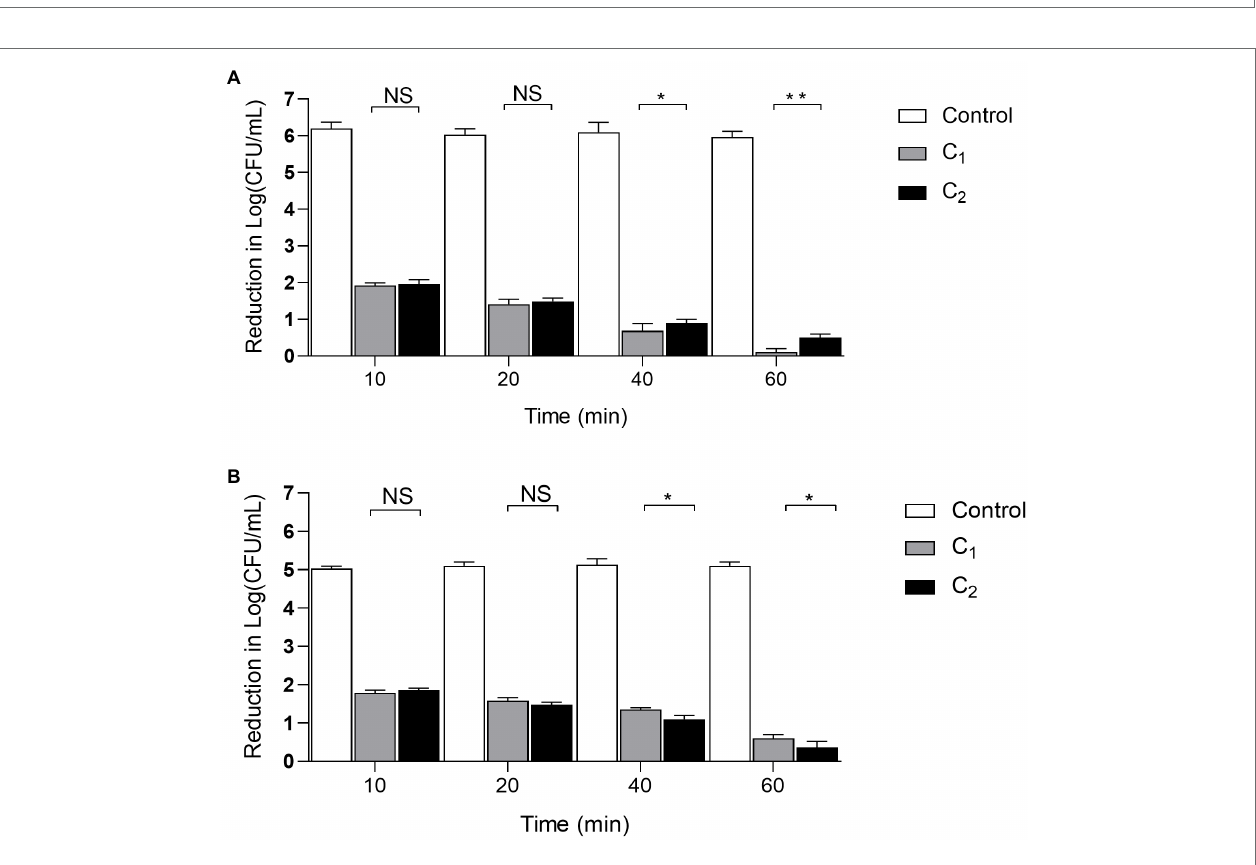
FIGURE 2 | Results of in vivo single-cell gel electrophoresis assay. C 1 , Compound disinfectant 1; C 2 , Compound disinfectant 2; M, N -dodecyl-2-(piridin-1-ium) acetamide chloride (C 12 cmpCl); NC, Negative control; and PC, Positive control. The arrow indicates the comet’s trailing tail.